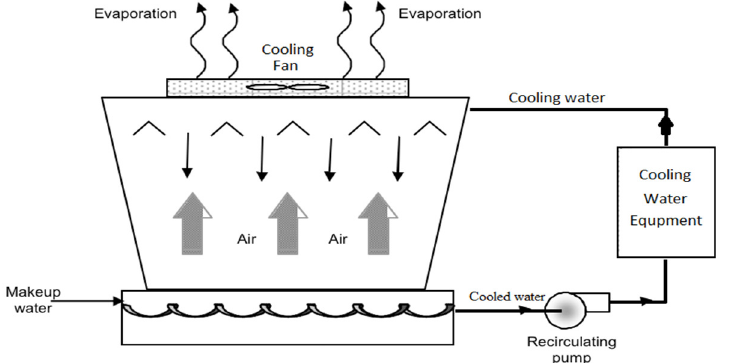
Fig. 2. Schematic diagram of cooling tower